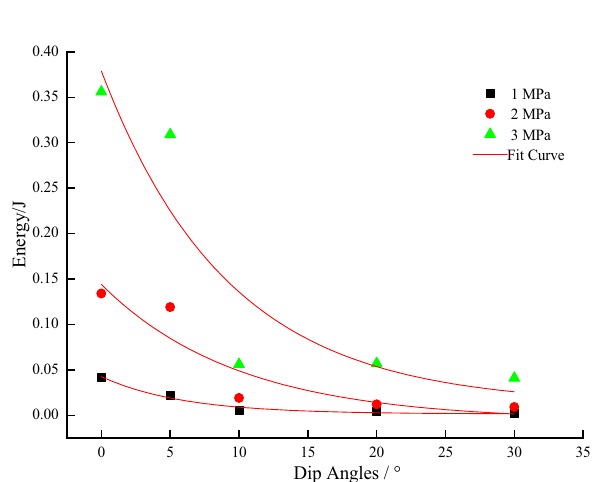
Figure 8. The relationship between the releasable elastic strain energy and the inclination